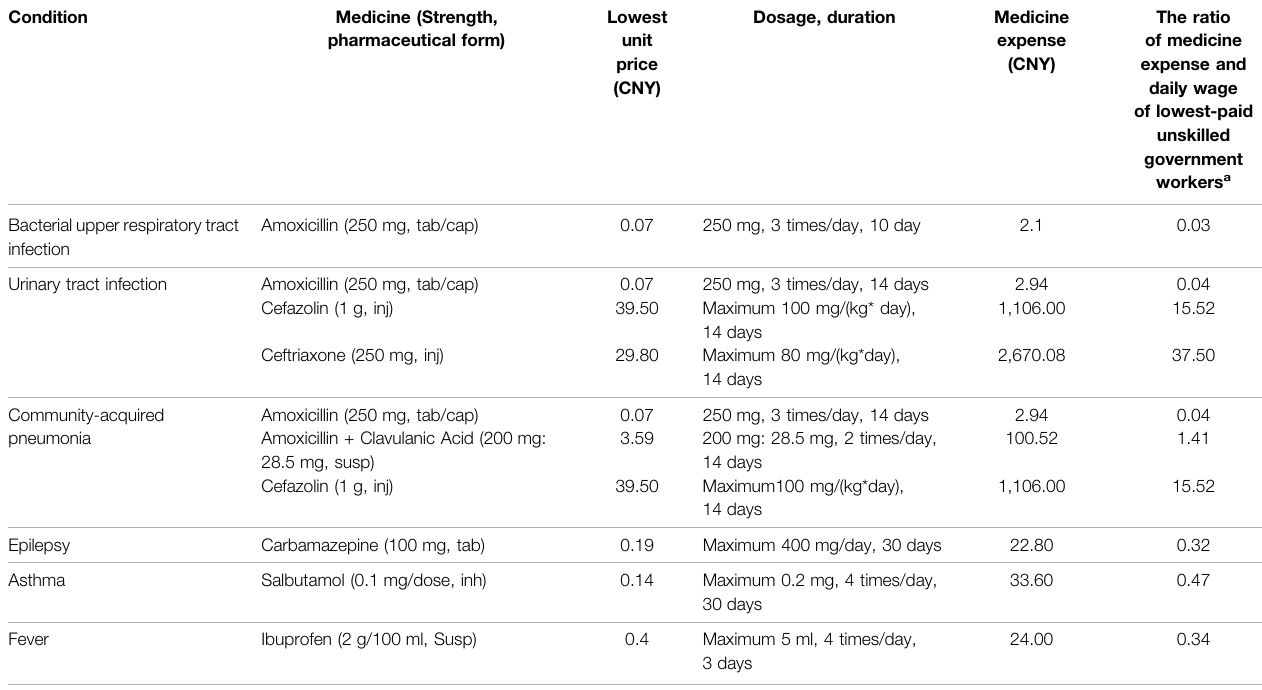
TABLE 6 | Affordability of medicines for children.